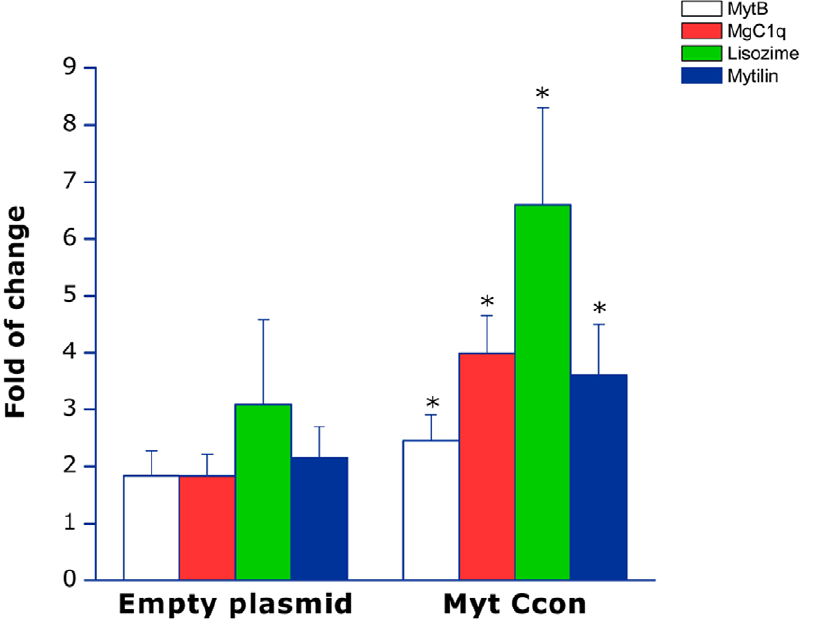
Figure 7. Expression pattern of immune-related genes induced by invivo overexpression of recombinant Myt C. Expression of a selected set of genes related to immune response in mussels. Mussels were injected in adductor muscle with 2.5 m g of pMCV1.4 empty plasmid or pMCV1.4-Myt Ccon-eGFP. Control mussels were injected with an equal volume of PBS. The results represented as the mean 6 SEM of three different biological replicates in a representative experiment. Asterisks indicate significant differences (p , 0.05) in gene expression in mussels injected with pMCV1.4 empty plasmid or pMCV1.4-Myt Ccon-eGFP relative to the expression of PBS-injected mussels, previously normalized to 18S transcript levels. White bars, myt b ; red bars, mgc1q ; green bars, lysozyme and blue bars, mytilin b